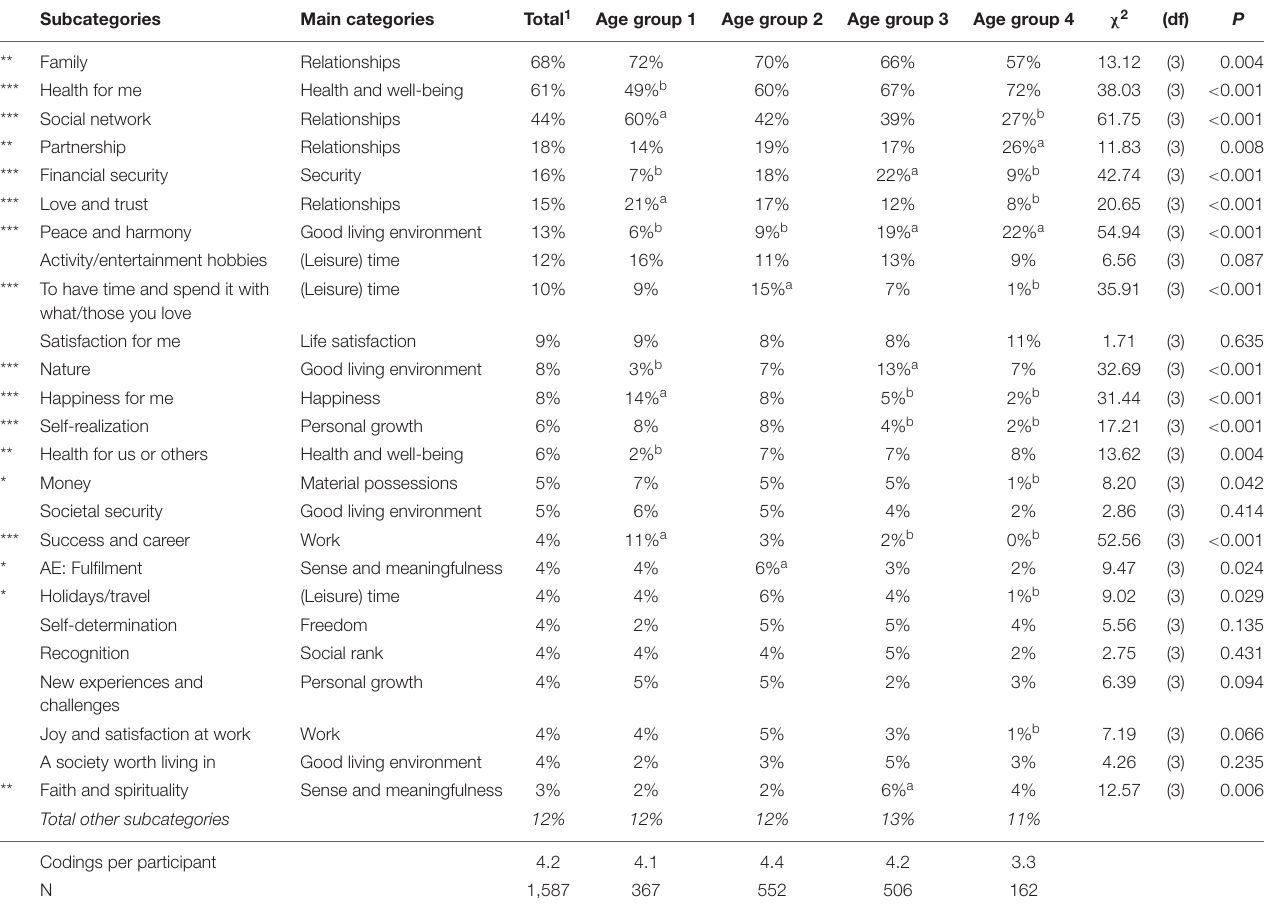
TABLE 3 | Distribution of responses across the subcategories for the overall study population and according to different age groups.